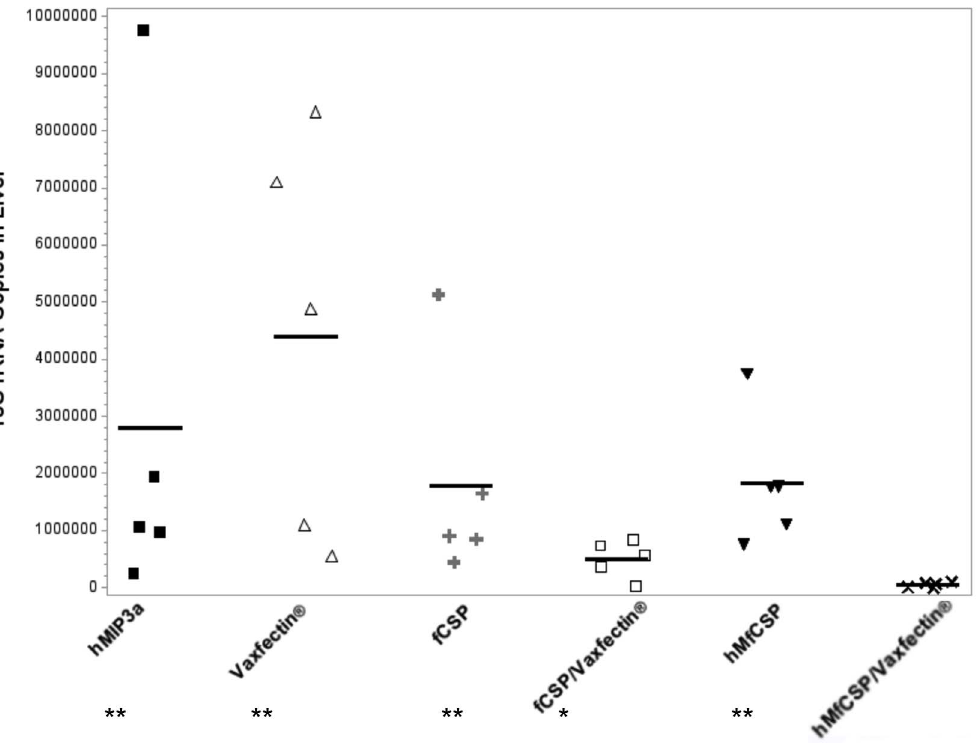
Figure 9. Protective efficacy of different vaccine constructs in C57BL/6 mice challenged with transgenic P.berghei expressing P. falciparum CSP. C57BL/6 mice were immunized with 5 m g of the indicated DNA vaccine as described in the Methods section. Two weeks after the final immunization, mice were challenged with 5 6 10 3 transgenic P.berghei sporozoites, and parasite-specific rRNA levels in the liver were determined by quantitative RT-PCR on samples obtained 48 hours post challenge. All results were normalized against the expression of actin. Results indicate the copy numbers from individual mice (closed squares) and the mean from the 5 mice in each group (lines). ** Compared to hMfCSP/Vaxfectin p , 0.001. *Compared to hMfCSP/Vaxfectin p , 0.05. No other differences among groups were statistically